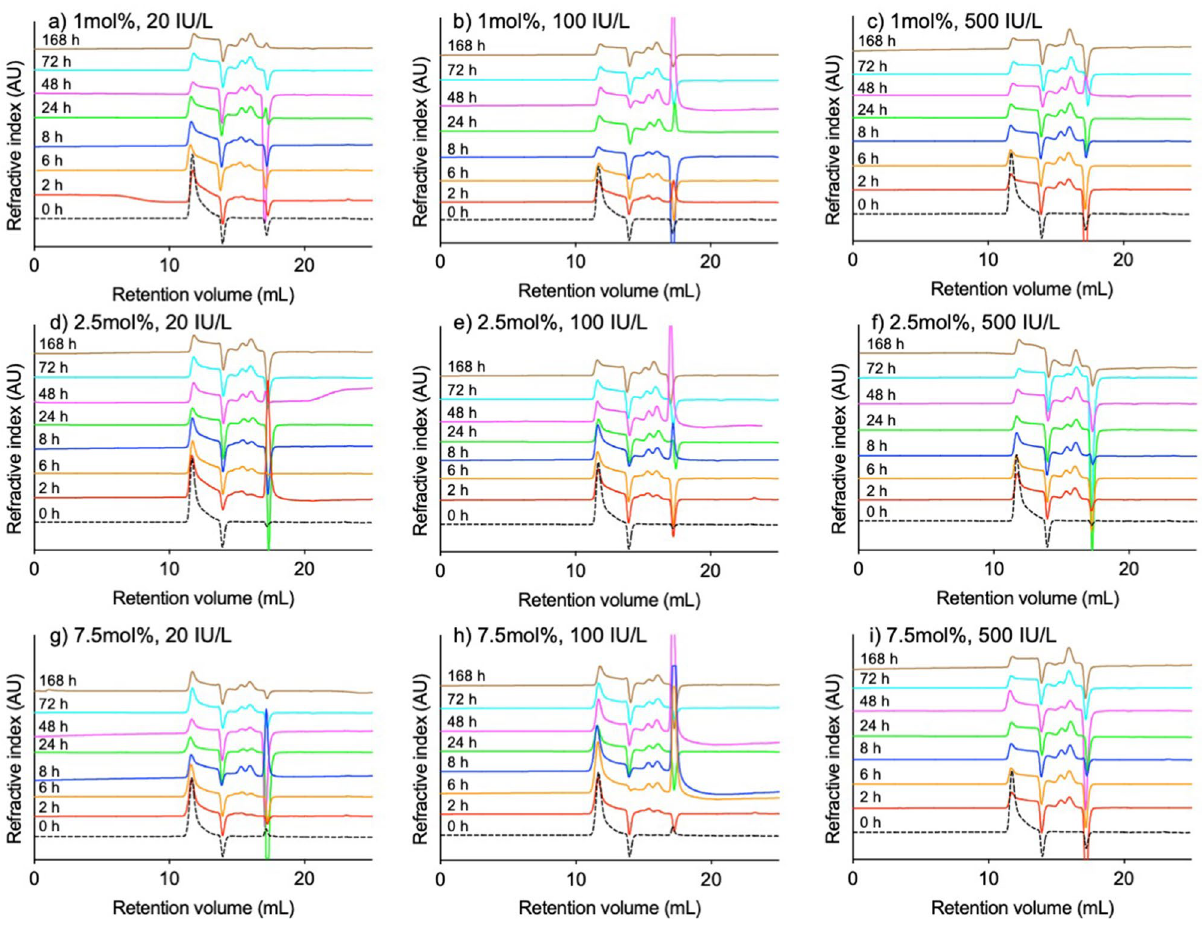
Figure 5. GPC chromatograms showing refractive index (RI) of dextrin-colistin conjugates with ( a - c ) 1 mol%, ( d - f ) 2.5 mol% and ( g - i ) 7.5 mol% succinoylation following incubation with amylase (0, 20, 100 and 500 IU/L) at 37 °C for 0 (dotted line), 2 (red line), 6 (yellow line), 8 (dark blue line), 24 (green line), 48 (pink line), 72 (light blue line) and 168 (brown line)